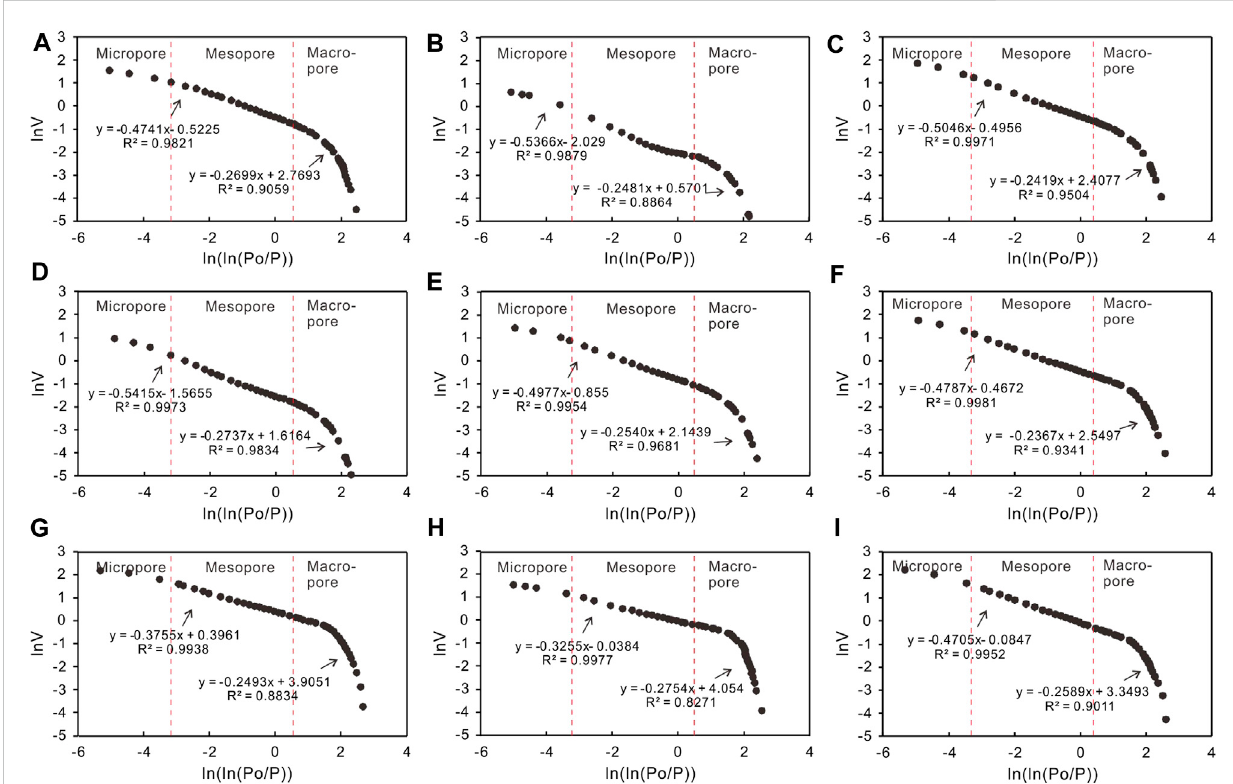
FIGURE 9 Schematic diagram showing fractal fi tting of Jurassic Lianggaoshan Formation lacustrine shale in different lithology combination. Micropore, mesopore, and macropore are represented as the blue, red, and black hollow circles, respectively. (A) Type A shale, Well A, 2161.25 m; (B) Type A shale, Well B, 2455.06 m; (C) Type A shale, Well C, 1764.7 m; (D) Type B shale, Well D, 2437.33 m; (E) Type B shale, Well E, 1751.71 m; (F) Type B shale, Well C, 1894.02 m; (G) Type C shale, Well A, 2164.49 m; (H) Type C shale, Well D, 2465.48 m; (I) Type C shale, Well C, 1928.58